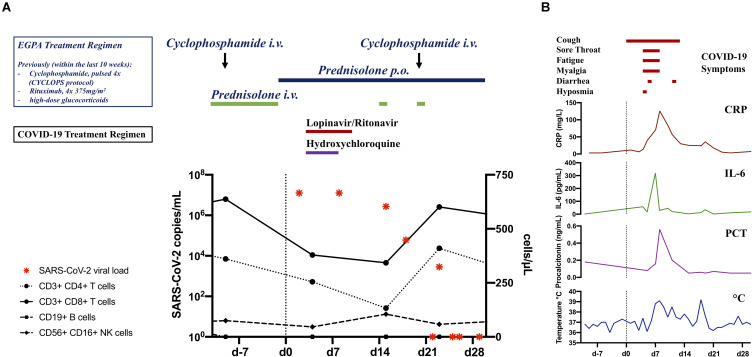
(A) Timeline of SARS-CoV-2 real-time reverse transcription PCR results (copy numbers) and numbers of immune cells during COVID-19. Colored bars indicate treatment regimen employed pre and post SARS-CoV-2 infection. (B) Course of COVID-19 induced inflammation markers quantified in patient sera including CRP, IL-6, procalcitonin (PCT), and body temperature (°C). Colored lines indicate patient symptoms related to SARS-CoV-2 infection. Vertical dashed line indicates onset of COVID-19 related symptoms.